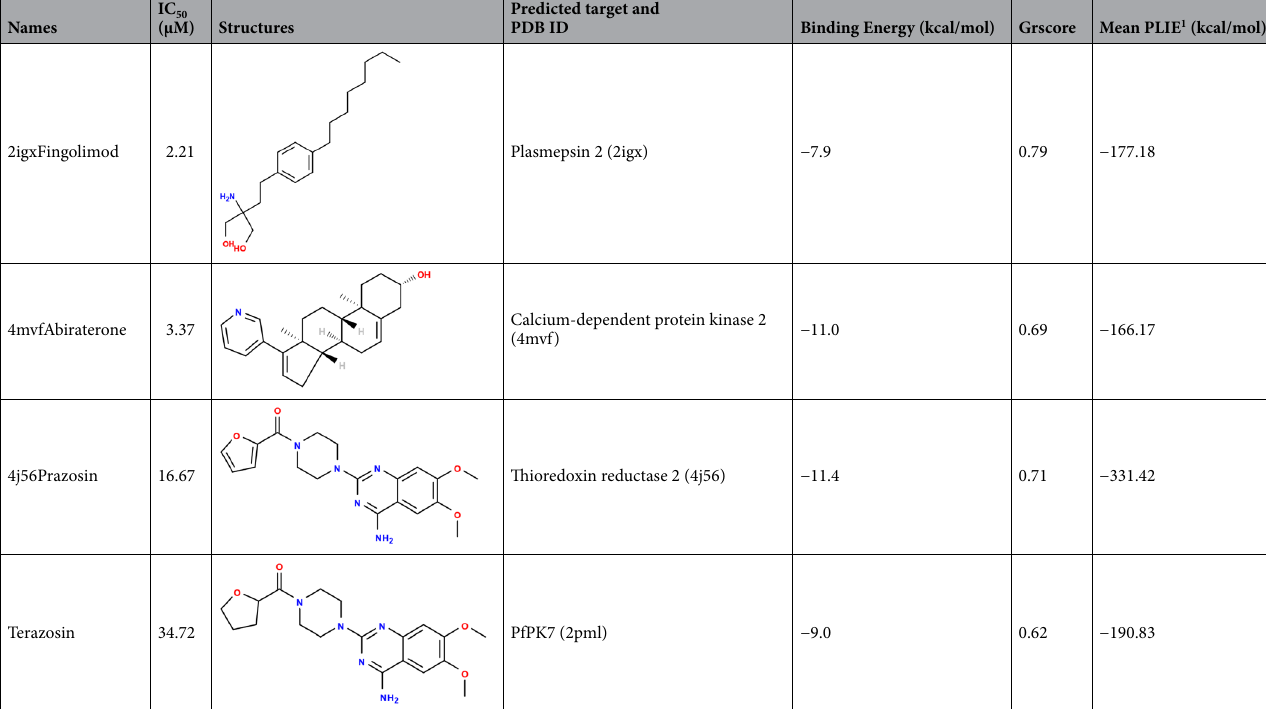
Table 1. Active compounds with their targets names, PDB IDs, QuickVina-W binding energies, GRIM Grscores and IC 50 . All other systems are in Supplementary Table S2. Structures’ drawings were obtained from DrugBank 86 . Structures were depicted with Open Babel 87 . 1 PLIE: Protein–ligand interaction energy.